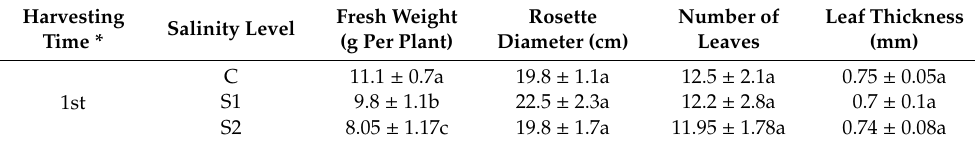
Table 1. Plant growth parameters of Centaurea raphanina subsp. mixta leaves in relation to